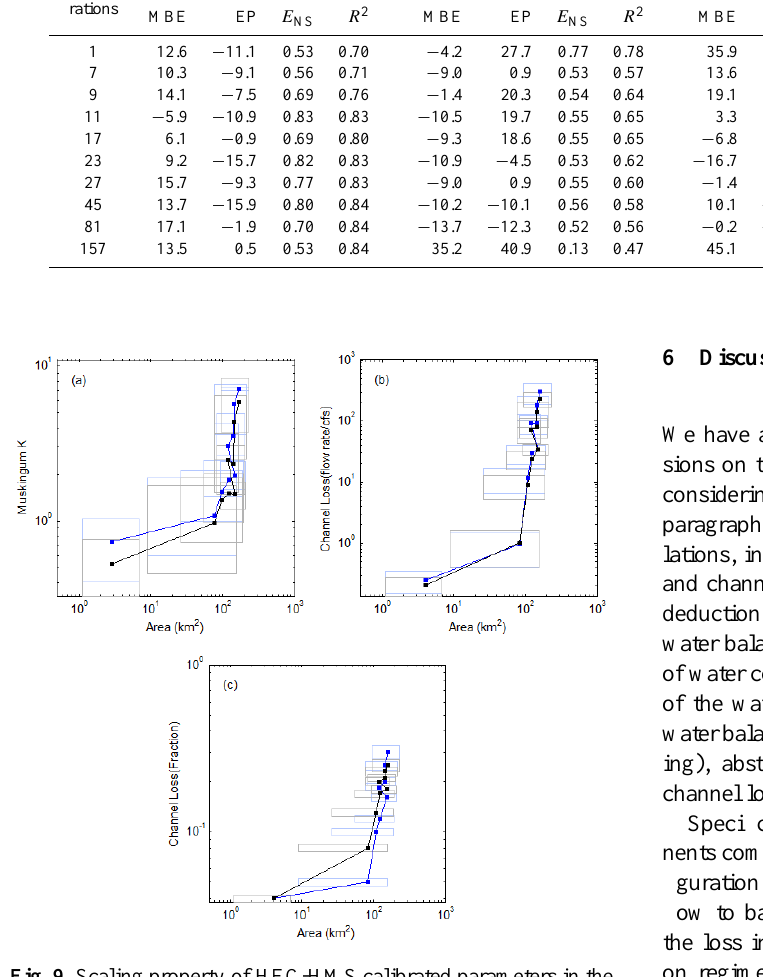
Table 2. Calibration performance indicators for 10 configurations and 2 flood events (with 4 simulation scenarios). Configu-